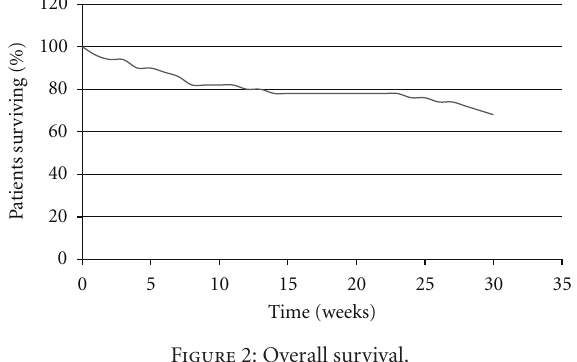
Figure 2: Overall